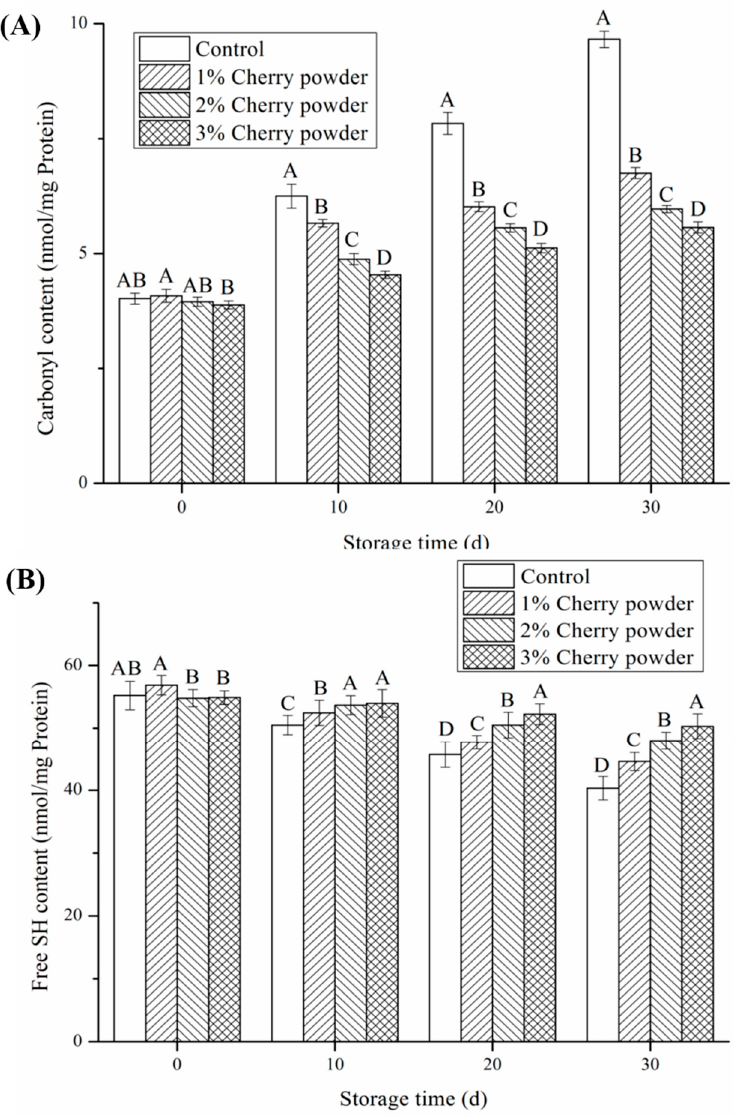
Figure 2. Effects of cherry powder addition on protein oxidation of Jiangsu-type sausage during storage. ( A ): carbonyl content, ( B ) Free SH content. Note: Different letters (A, B, C, D) indicate a significant difference ( p < 0.05).